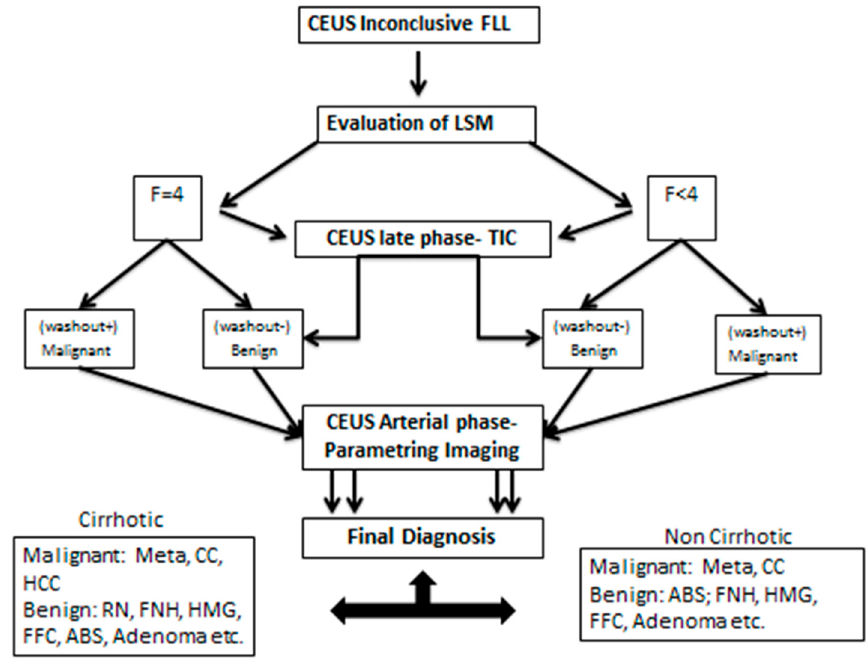
Figure 7. The binary tree decision classifier with the decision steps and possible alternatives.